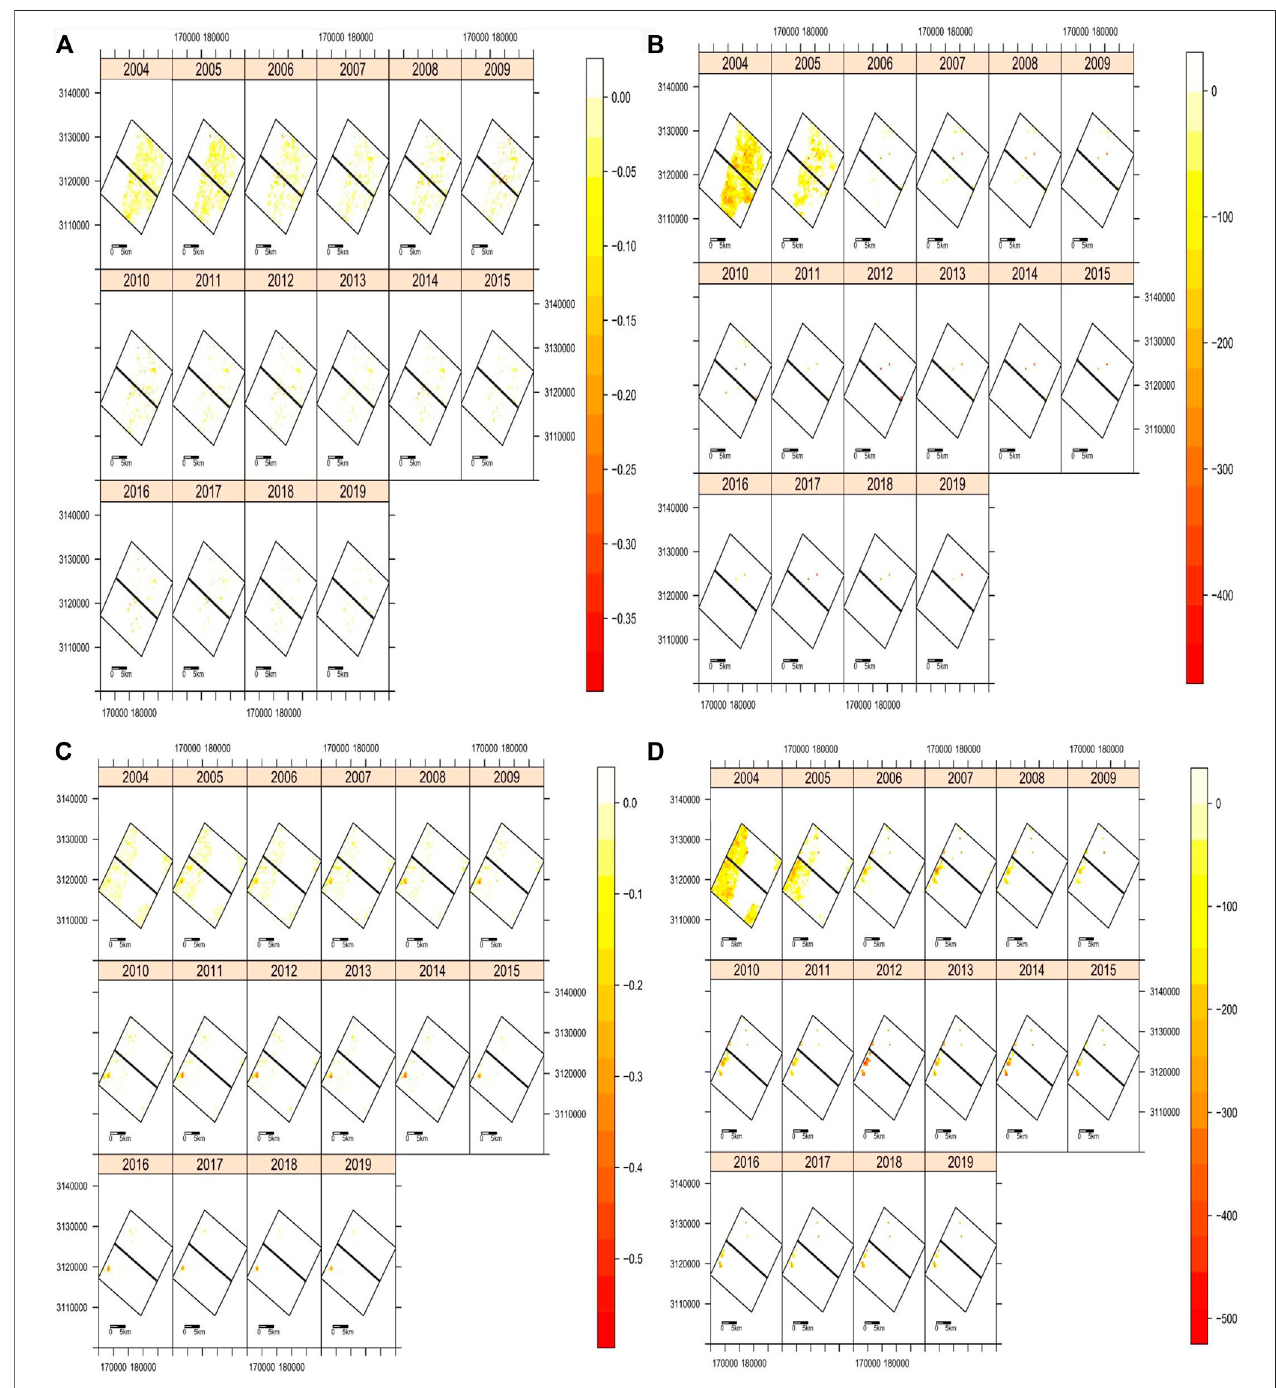
FIGURE 6 | Spatial distribution of negative NDVI (A,C) and GPP (B,D) throughout DC and AC in the karst (A,B) and non-karst areas (C,D) .